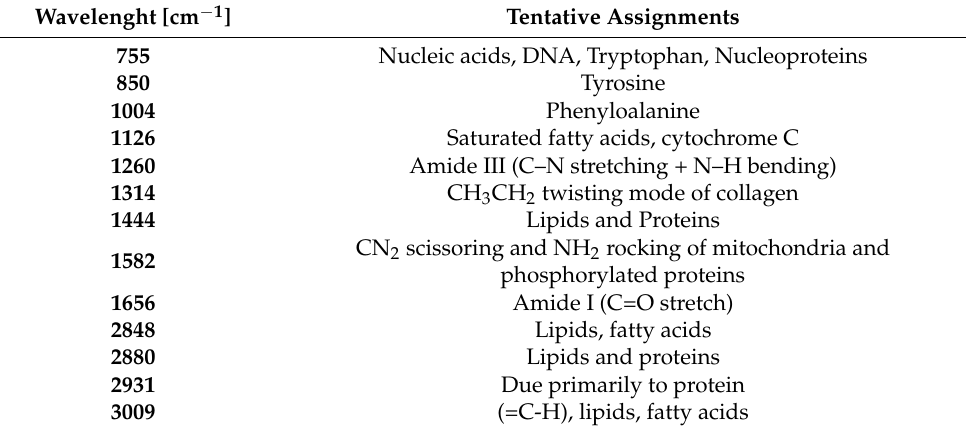
Table 1. Band positions and tentative assignments for human normal colon cells from control sample, in oxidative stress conditions generated by adding tBuOOH (discussed later in the manuscript) and for the experiments for vitamin C supplementation. Data based on the average Raman spectra for cells as a whole measured in PBS, excitation laser line 532 nm